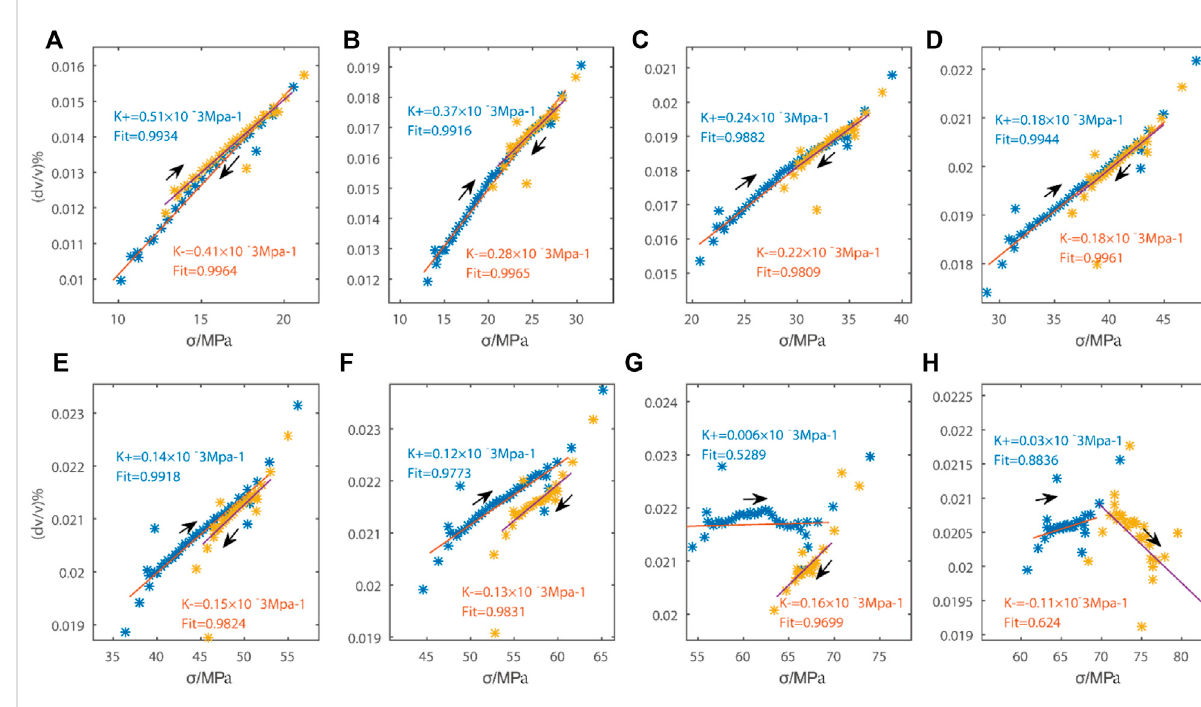
FIGURE 11 Change rate of coda wave velocity in each loading and unloading stage (A – H) .